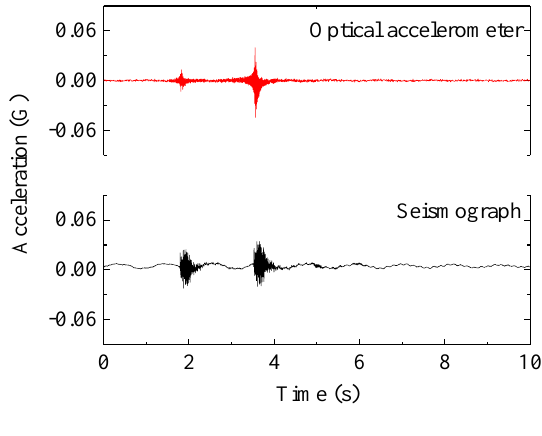
Figure 6. Acceleration data recorded with the optical sensor and seismograph during the application of mechanical impulses, measured in the transversal